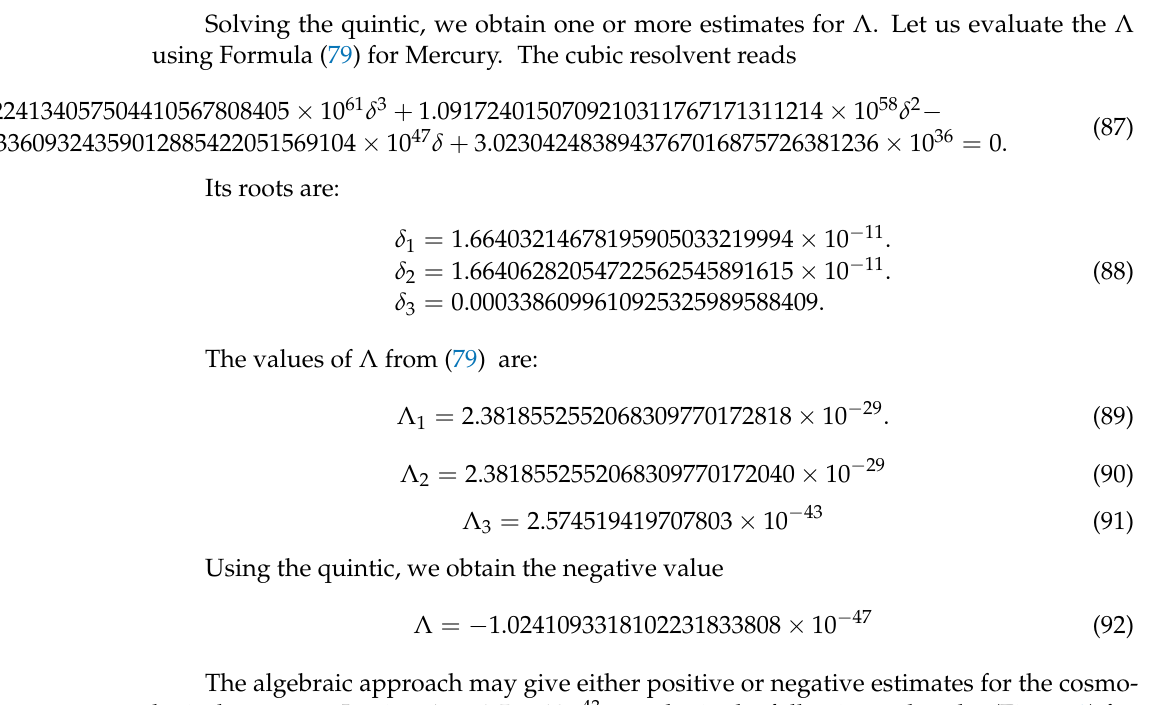
Figure 3. Mercury(cid:146)s trajectory using the ode (28) with (cid:3) = (cid:3)